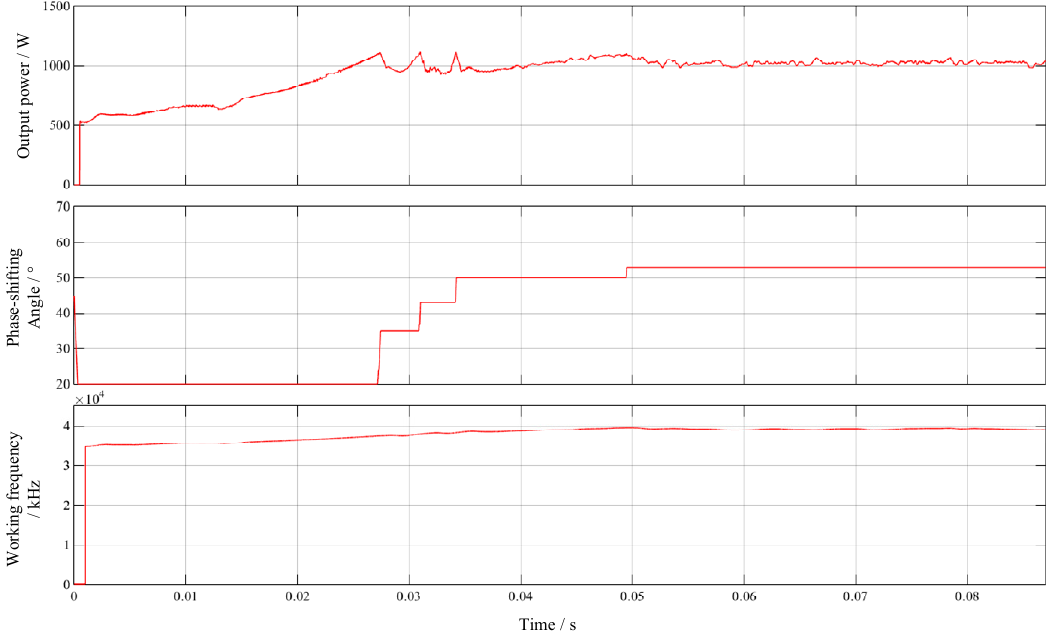
Figure 15. Simulation waveform of hybrid modulation algorithm.